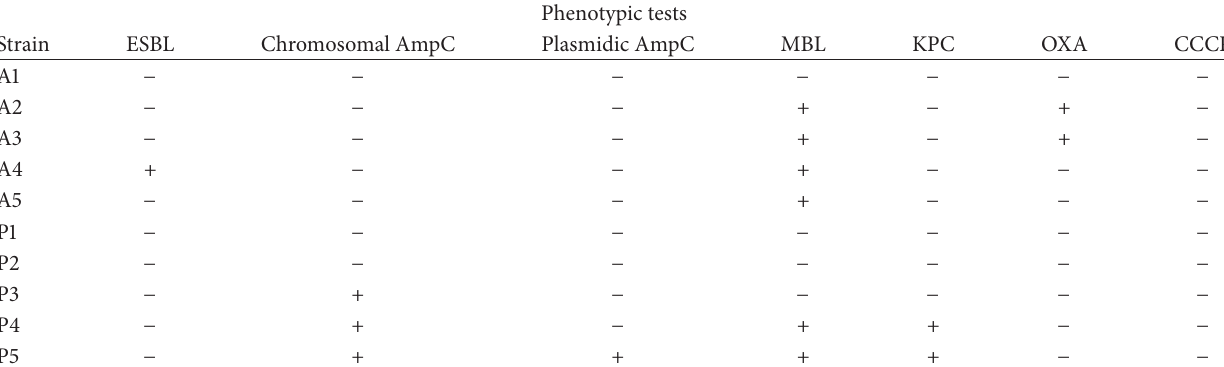
Table 3: Results of the phenotypic